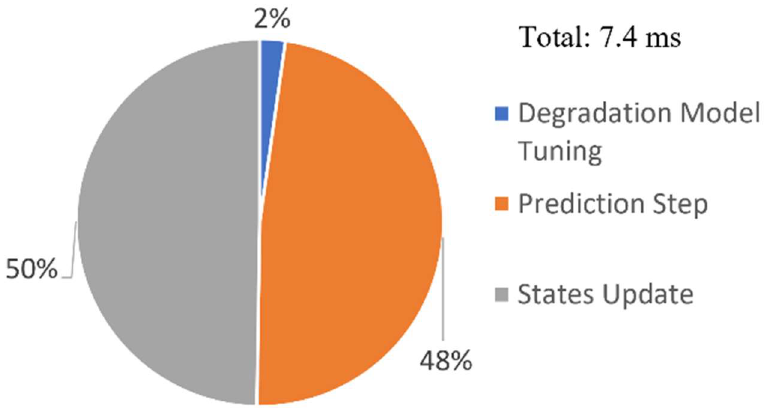
Figure 21. Elapsed time breakdown—average execution time of a particle-filtering step.